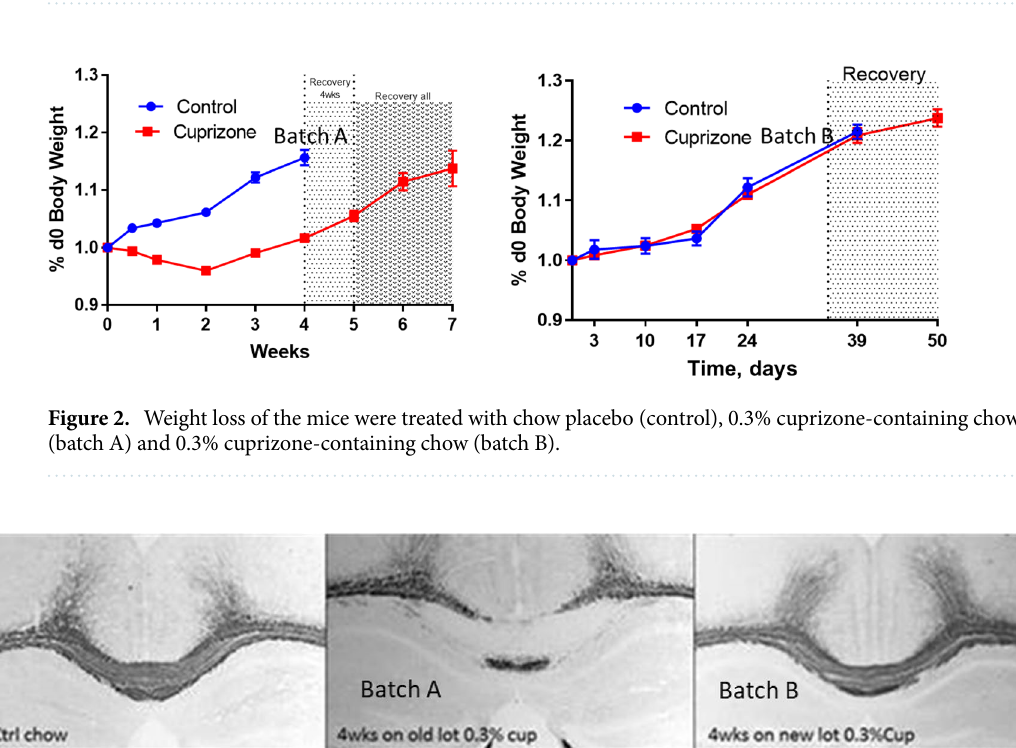
Figure 1. Chemical structure of cuprizone.